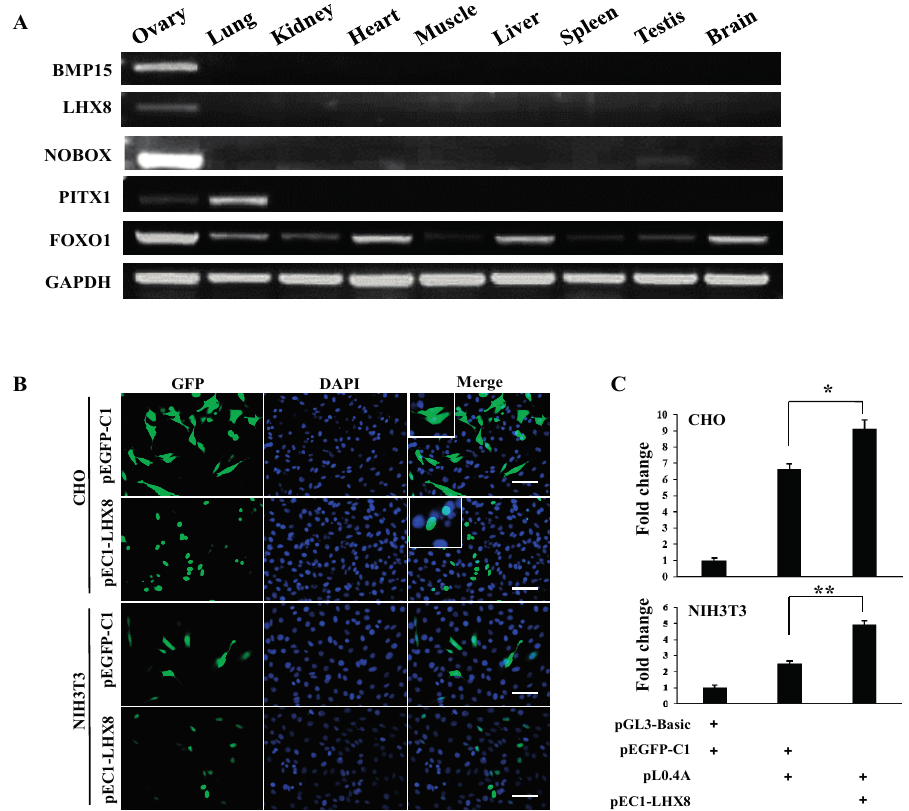
Figure 5. LHX8 enhances the activation of BMP15 promoter. ( A ) RT-PCR analysis of expression of transcription factors in different porcine tissues; ( B ) Overexpression of LHX8 in CHO and NIH3T3 cells. The plasmid pEGFP-C1 was used as control. Scale bar, 100 μ m; and ( C ) Luciferase assays of BMP15 promoter activity that was enhanced by LHX8 were performed by cotransfection of vectors into CHO and NIH3T3 cells for 36 h. +, indicats a vector was transfected into the recipient cells. Values are represented as mean ± SD. * p < 0.05; ** p < 0.01; n =